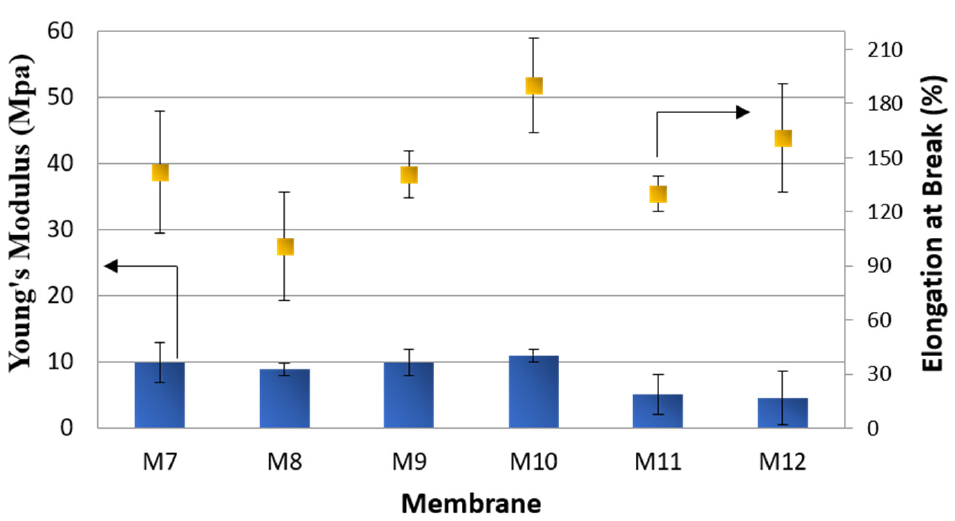
Figure 8. Mechanical properties of M7–M12 membranes.